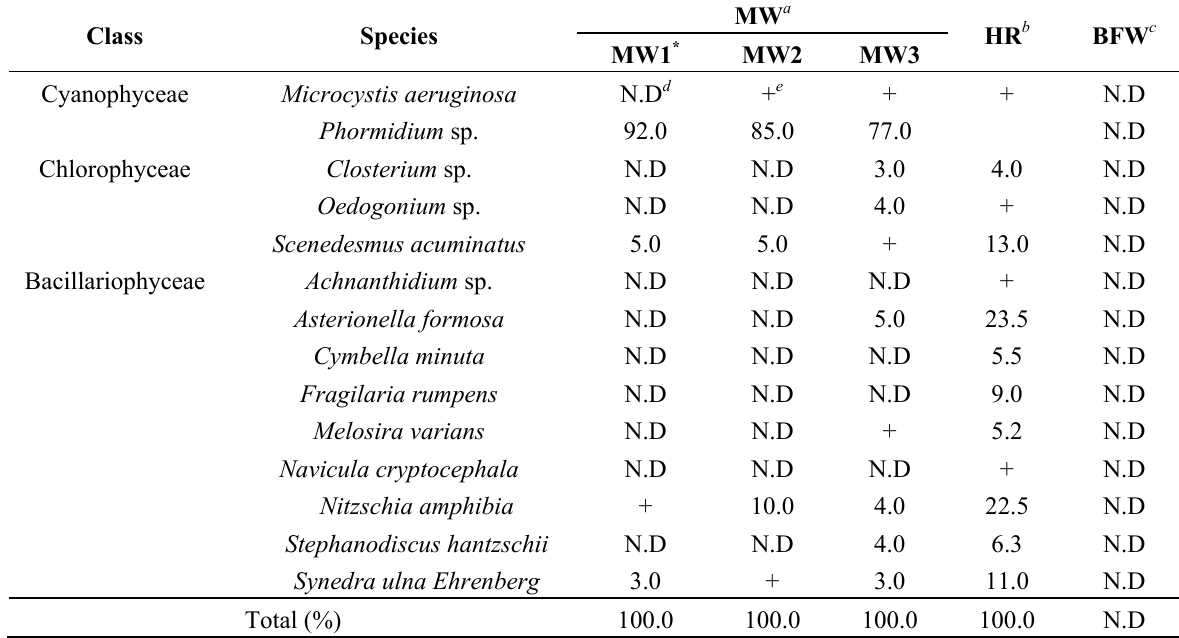
Table 3. Summary of species compositions (%) for periphyton collected from the sediments in three water sources sampled in April 2010.